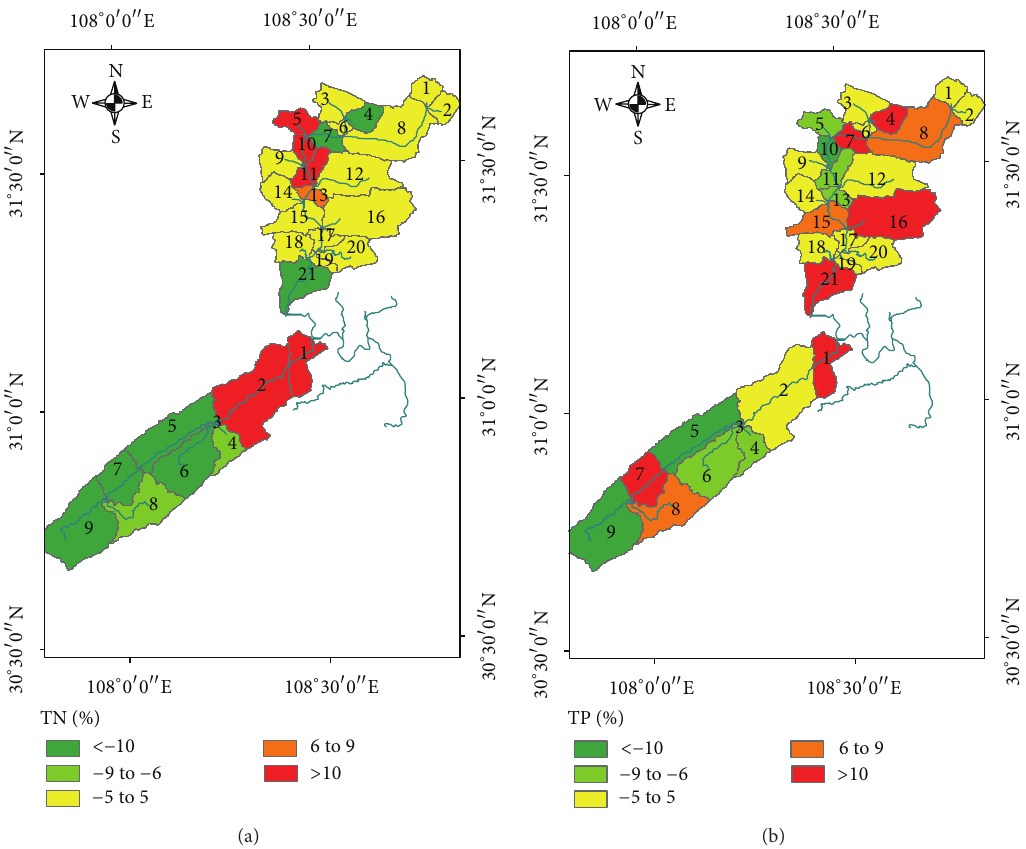
Figure 6: Spatial variation of water quality from 2000 to 2010 (a) percent change in TN; (b) percent change in